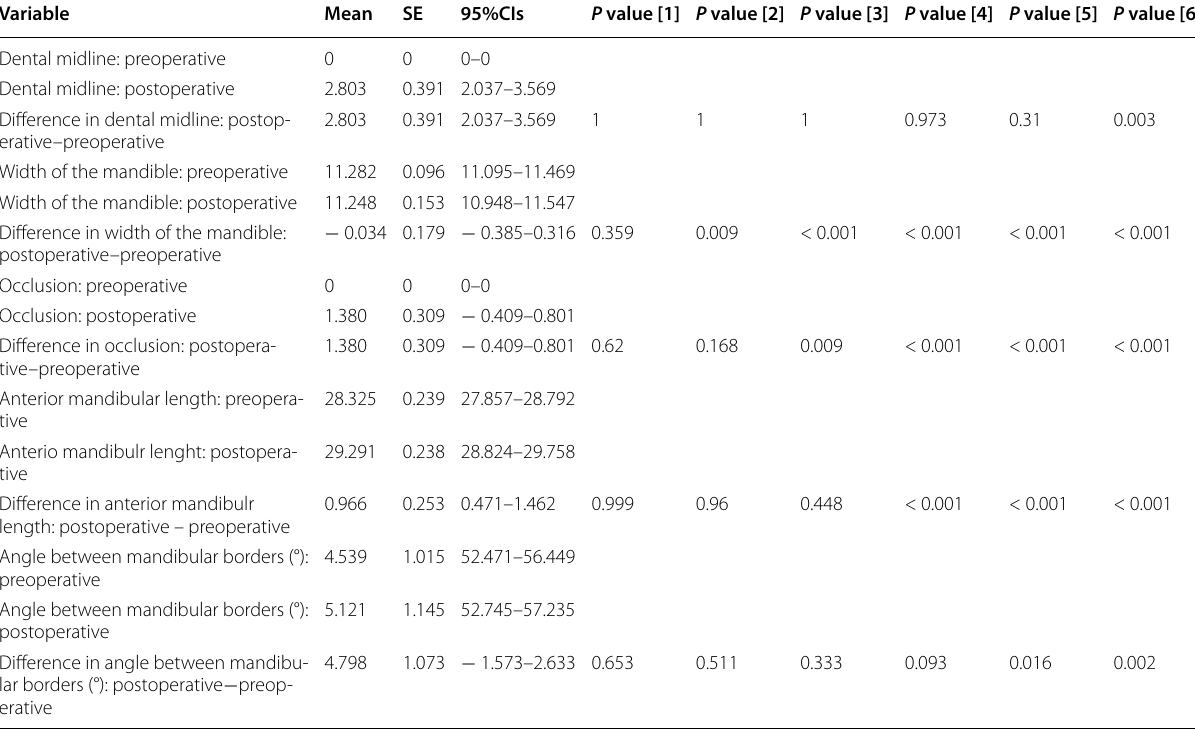
Width of the mandible: distance between the lingual cusps of the first mandibular molars Occlusion: distance between the maxillomandibular first molars Anterior mandibular length: distance between the mesial plane of the first mandibular molars to the incisal edge of the mandibular incisors